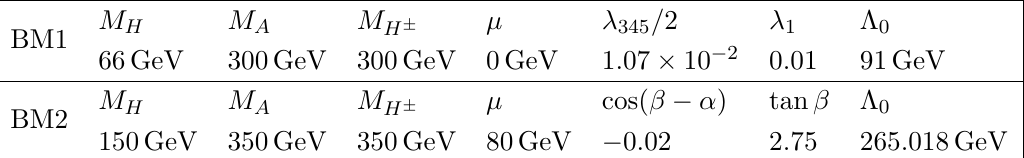
p (cid:0) (cid:22) 2 represents the soft 12